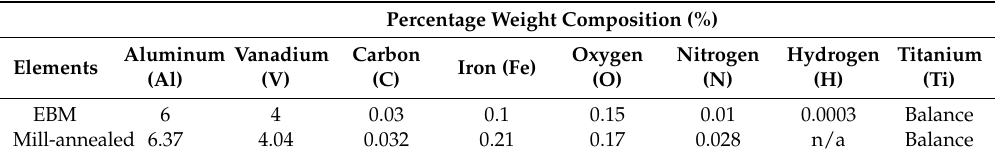
Table 1. Chemical compositions of Ti6Al4V powder for electron beam